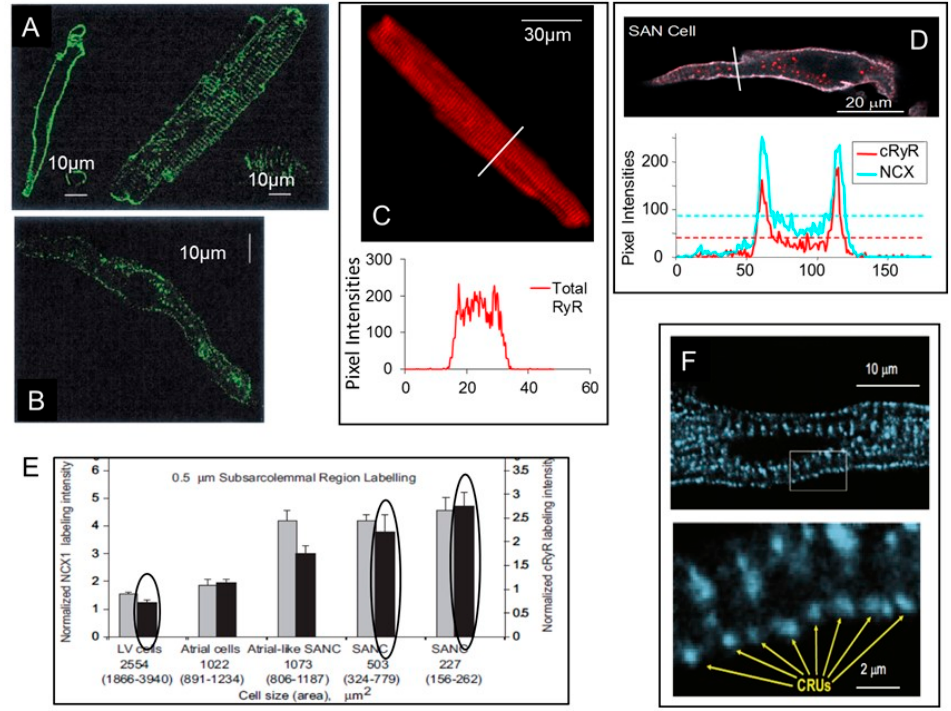
Figure 3. Distribution of ryanodine receptors (RyRs) and Na + /Ca 2+ exchanger (NCX) in SANC. ( A ) The surface membrane labeled with di-8-ANEPPS in guinea-pig SANC (left panel) and VM (right panel) showed that SANCs, in contrast to VMs, have no invaginations associated with T-tubules (modified from Rigg et al. [21]). ( B ) Immunolabeling of guinea-pig SANC with anti-RyR antibody identified higher labeling intensity close to sarcolemma (modified from Rigg et al. [21]). ( C ) Immunostaining of rabbit saponin-permeabilized VM for total RyR (top) and the average pixel intensity (bottom) showed an even labeling intensity across the cell (modified from Sirenko et al. [35]). ( D ) An example of double immunolabeling of intact rabbit SANC with NCX and RyR antibodies (top); pixel-by-pixel intensities showed that NCX and RyR are colocalized in the submembrane regions of SANC (modified from Lyashkov et al. [61]). ( E ) Quantitative analysis of labeling intensities within a 0.5 μ m subspace beneath the perimeter of the sarcolemma confirmed the significant increase in both NCX (grey bars) and RyR (black bars) in SANC compared to that in left ventricular (LV) myocytes (NCX1 labeling in SANCs differs from LV and right atrial cells by p < 0.05 post hocANOVA. cRyR labeling of SANCs differ from LV and right atrial cells, p < 0.01 post hoc ANOVA, modified from Lyashkov et al. [61]). ( F ) In rabbit SANC, immuno-fluorescence of RyR clusters, i.e., local Ca 2+ release units (CRUs), showed their localization under the cell surface membrane with the average distance ~1.3 μ m (modified from Maltsev et al. [69]).